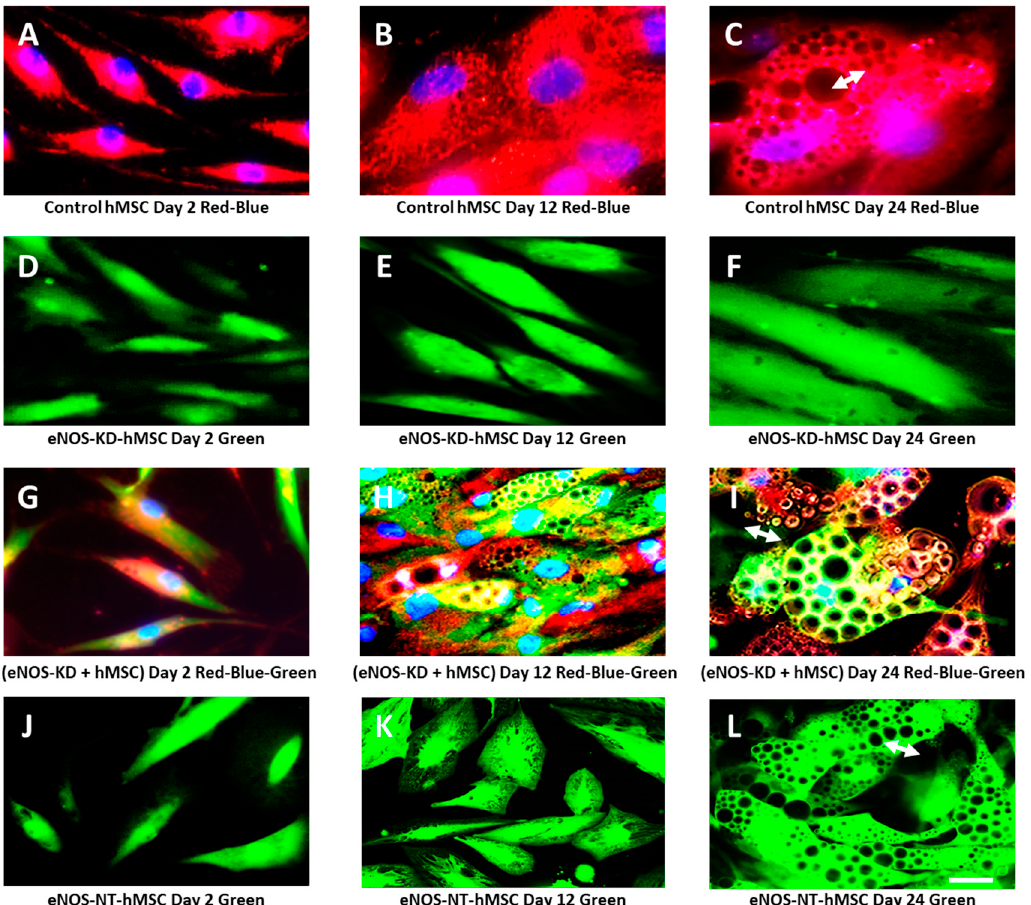
Figure 3. Live-cell real-time fluorescence images showing the effects of eNOS KD on adipogenesis and that mitochondria transfer from control hMSCs restores adipogenesis: ( A – C ) control hMSCs on days 2, 12, and 24 (red-blue overlay); ( D – F ) eNOS-KD-hMSCs on days 2, 12, and 24 (green); ( G – I ) co-cultures of eNOS-KD-hMSCs and control hMSCs on days 2, 12, and 24 (red-blue-green overlay); and ( J – L ) eNOS-NT-hMSCs on days 2, 12, and 24 (green).